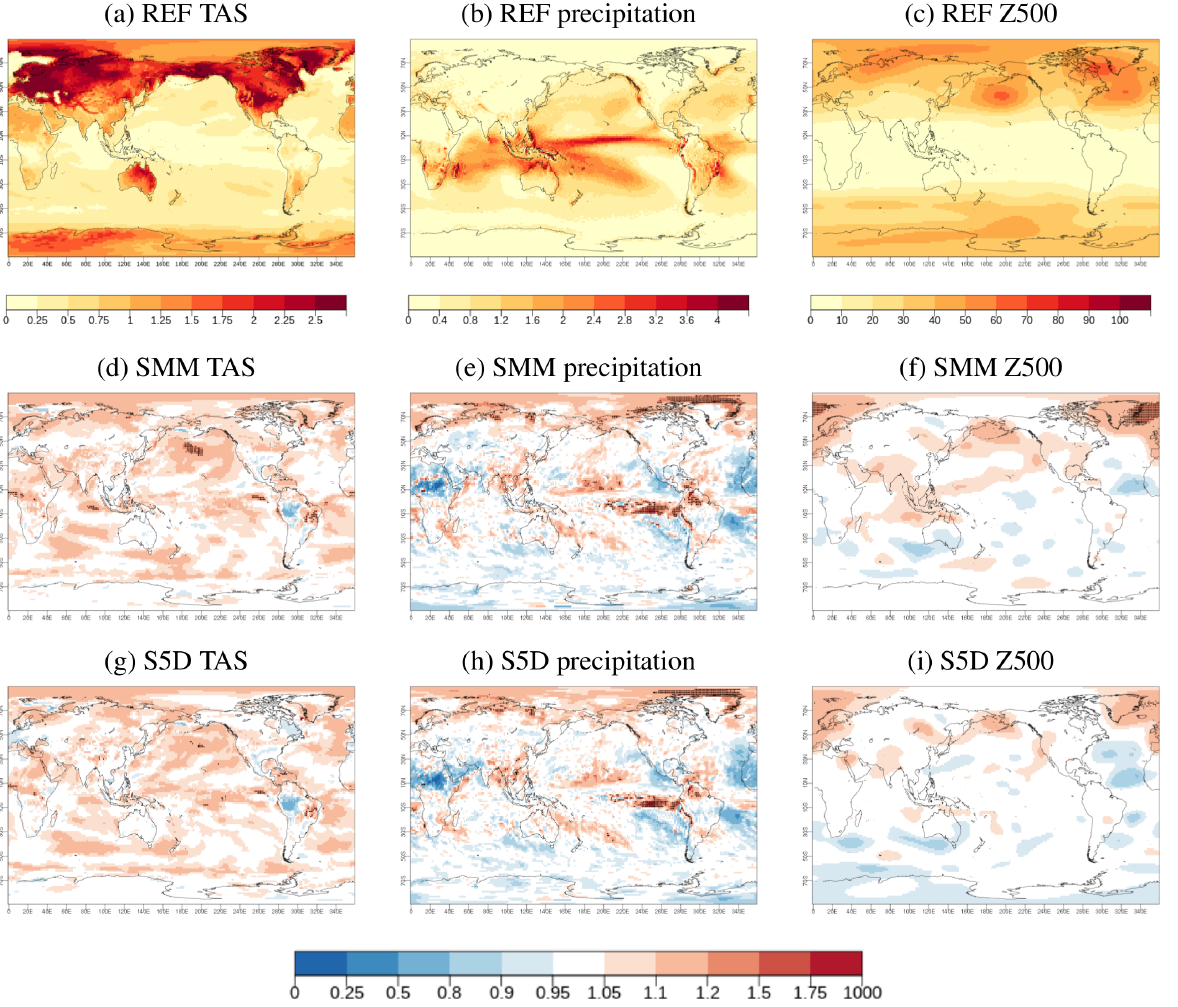
Figure 7. DJF spread (top row) for REF experiment near-surface air temperature, precipitation, and Z500 (from left to right); corresponding relative spread in experiments SMM and S5D (second and bottom rows, respectively). Spread is computed as the standard deviation around the ensemble mean. Areas in blue indicate where spread is lower with respect to REF, whereas areas in shades of red show where spread is increased, and dots show where differences are significant at a 95% level based on bootstrapping